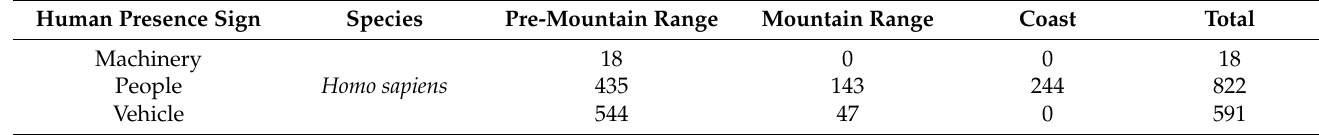
Table A2. Records of human presence by landscape in the coastal range of southern